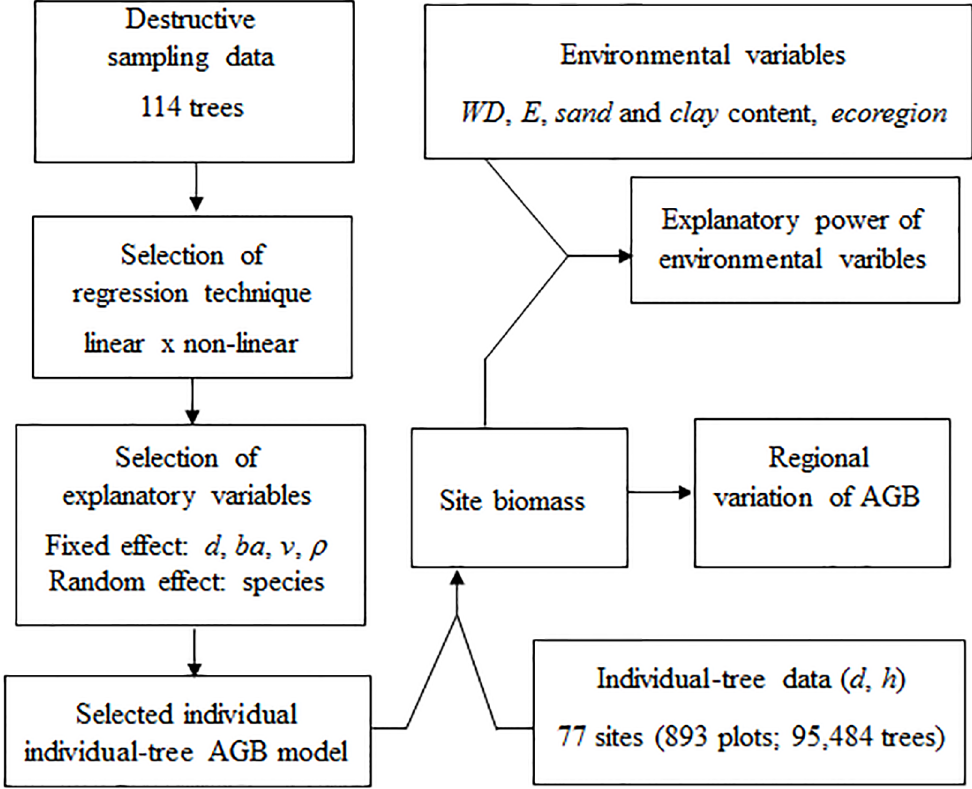
Fig 1. Methodological steps for developing an individual-tree aboveground biomass (AGB) model for cerrado sensu stricto in the cerrado, determining regional variation of tree AGB density, and evaluating environmental factors as explanatory variables. d = diameter, ba = basal area, v = volume, h = height, ρ = species wood density; WD = climatological water deficit; and E = environmental